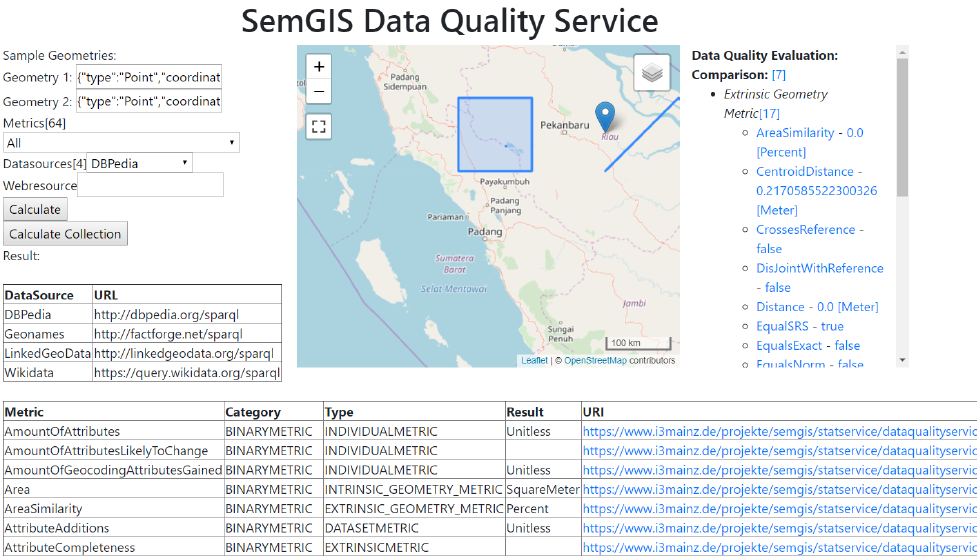
Figure 8. Data Quality Service: The data quality service provides data quality metrics which can be tested in a web interface. The service exposes these metrics as a webservice and as semantic web descriptions which are stored in the Data Quality Triple Store. If new data quality metrics are implemented, those are automatically added to the Data Quality Triple store where they can be data may take a triple store or other webservice as a comparison (gold standard)